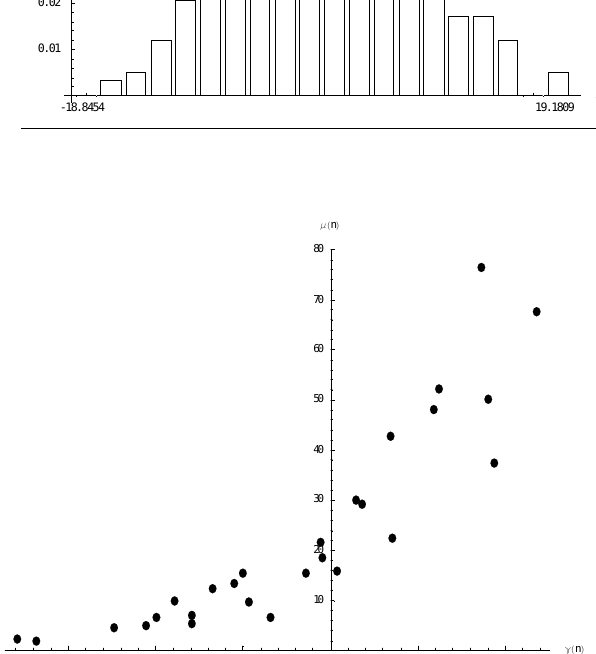
Fig. 6, with points